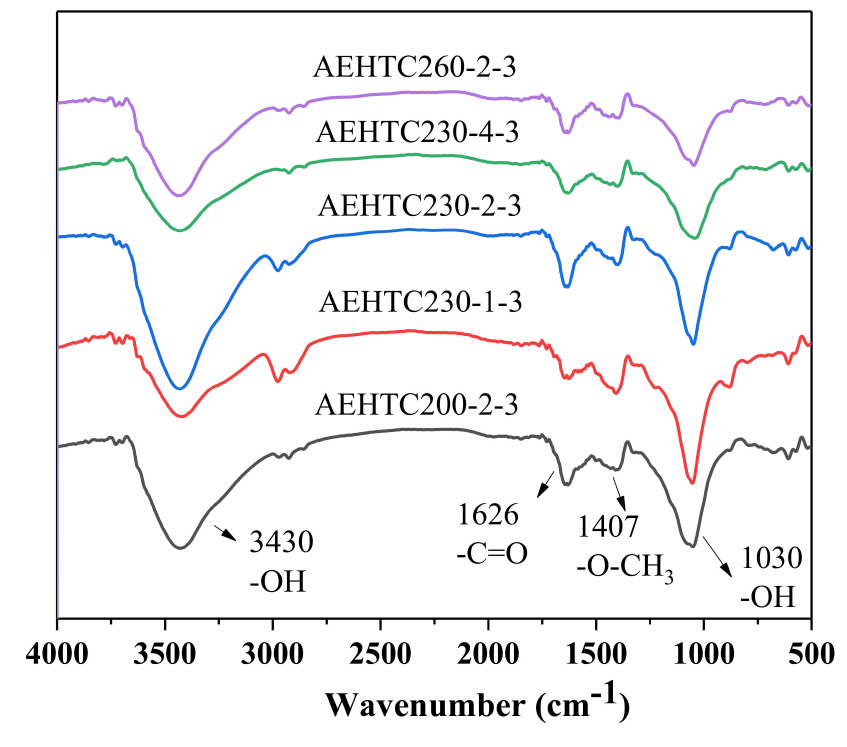
Figure 3. FTIR spectra of AE-CMIW